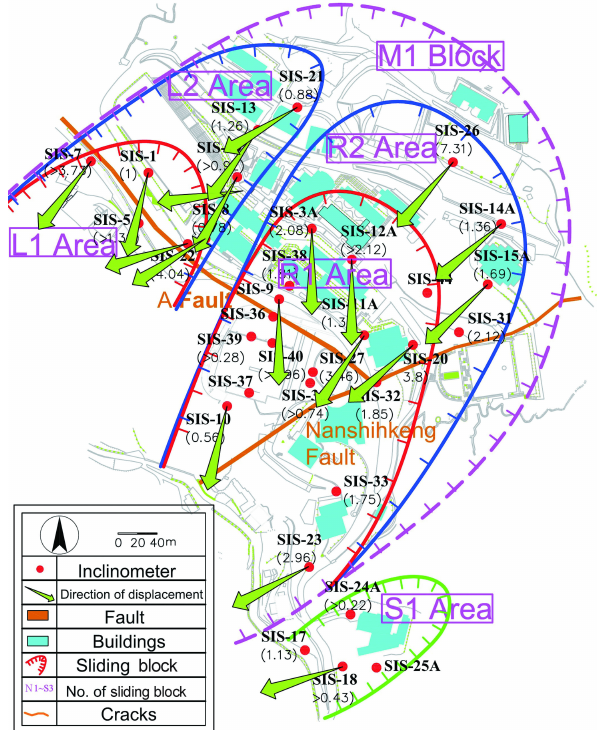
Figure 17. Sliding blocks with displacement directions within the campus. These results are derived from the inclinometer data and surface cracks observed over 2006 to 2008. Displacement rates inmmmonth − 1 are also shown in parentheses under the name of each inclinometer. The displacement rate, depth, and area of each block are important factors for slope stability analyses.